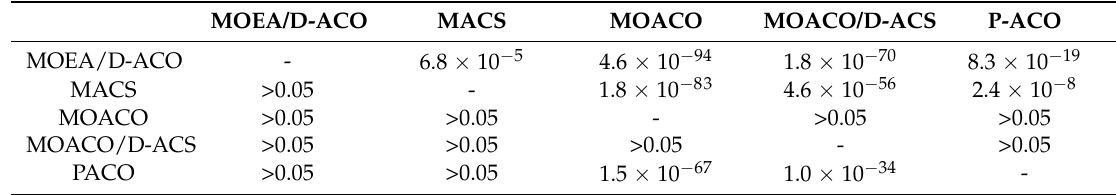
Table 10. Kruskal–Wallis test on kroAB150 based on H-indicator.